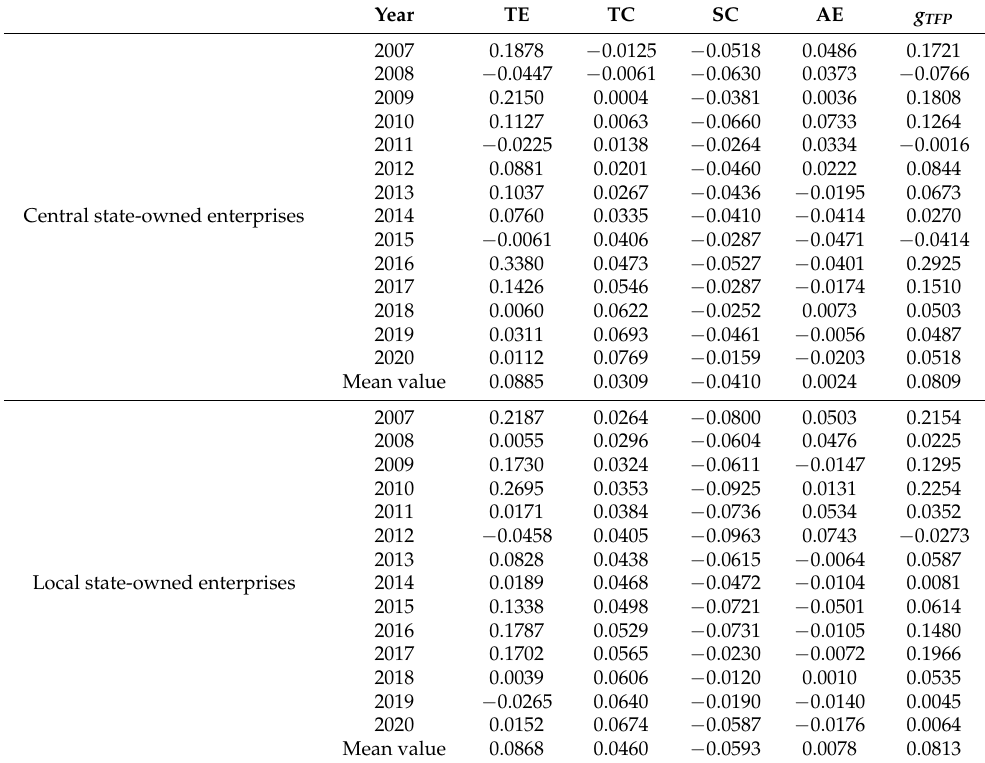
Table 6. SFA decomposition results of all ownership enterprises, from 2007 to